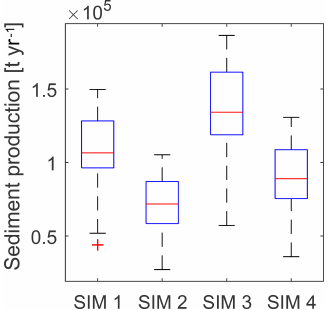
Figure 8. Sediment production in the basin as total sediment de- tached annually for the four simulations. Boxplots (median, in- terquartile range, and outliers) show the interannual variability in the period